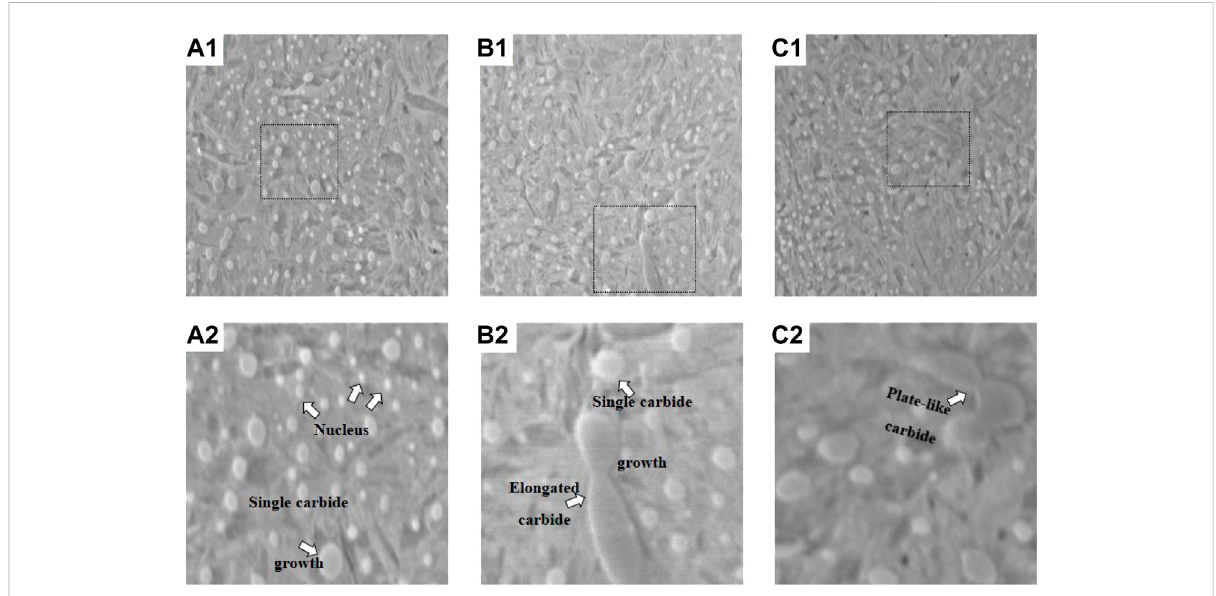
FIGURE 11 MicrostructureoftheGCr15 bearingouterringquenched atdifferentpositions. (A1) Neutralsurfaceofthequenchedpart. (B1) Outer surfaceof the quenched part. (C1) Inner surface of the quenched part. (A2) Local ampli fi cation of the neutral surface. (B2) Local ampli fi cation of the outer surface. (C2) Local ampli fi cation of the inner surface.